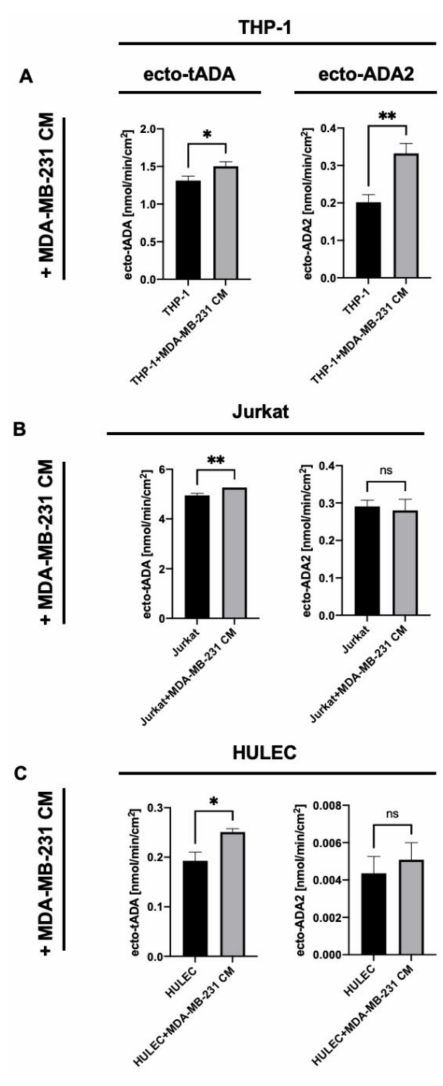
Figure 3. Total cell surface adenosine deamination rate (ecto-tADA) and ADA2 related cell sur- face adenosine deamination rate (in the presence of ADA1 inhibitor, EHNA) on human mono- cyte/macrophages (THP-1, A ), Jurkat cells ( B ), and human microvascular lung endothelial cells (HULEC, C ) after 48 h incubation with human triple negative breast cancer cell medium (MDA-MB- 231 CM). Results are shown as mean ± SEM, n = 6 − 9, * p < 0.05, ** p < 0.01 by Mann-Whitney